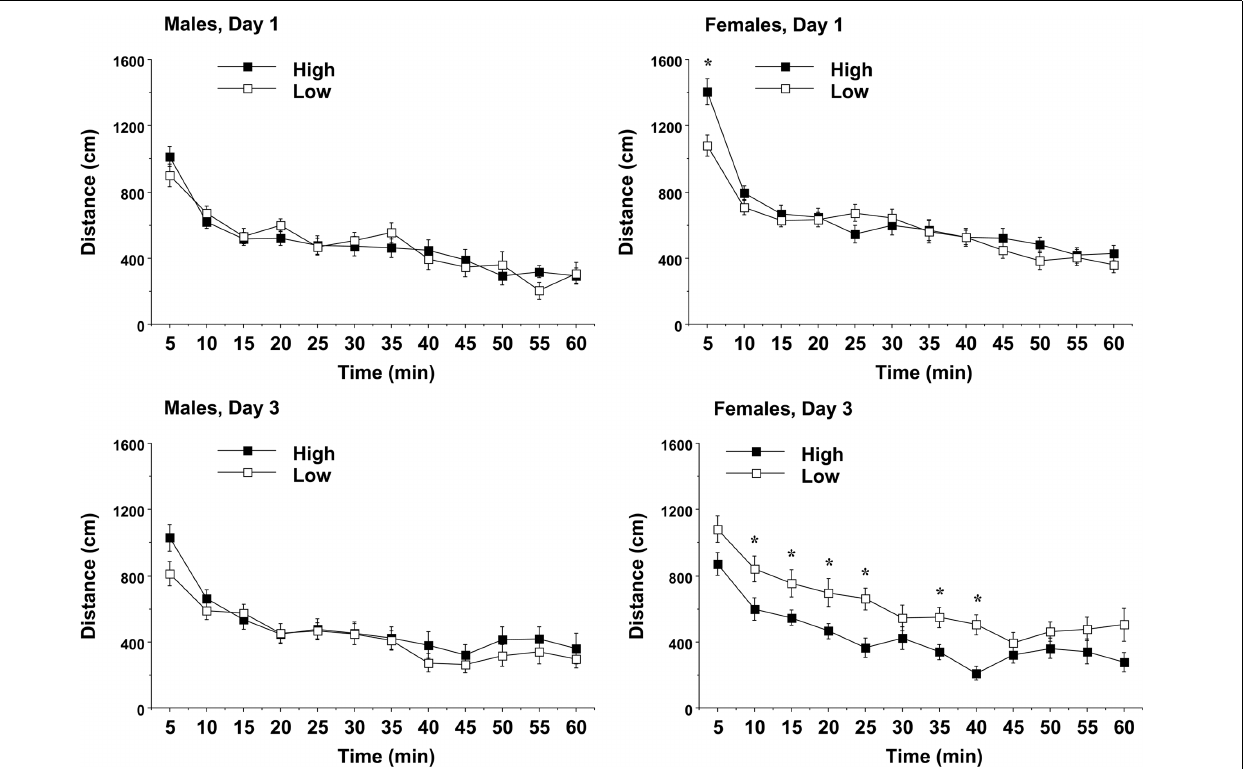
FIGURE 5 | Locomotion in a novel environment during a 1-h session. Data shown are means ( ± SEM) for the first (Day 1) and third (Day 3) tests. Female offspring of dams with low levels of pup-licking had significantly lower locomotion on Day 1, but higher locomotion on Day 3, than the offspring of high-licking dams. * p < 0.05.